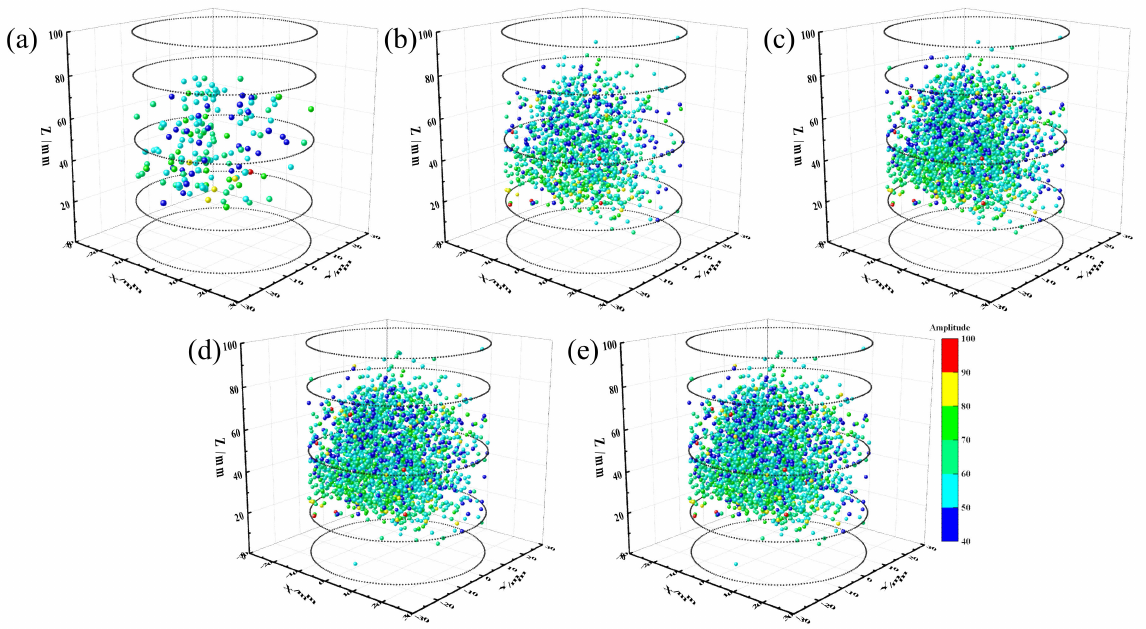
Figure 10. Spatial evolution of AE events of coal samples under different loading rates (1.0 mm/min): ( a ) crack compaction phase, ( b ) crack initiation phase, ( c ) stable crack growth phase, ( d ) unstable crack growth phase, and ( e ) post-peak failure